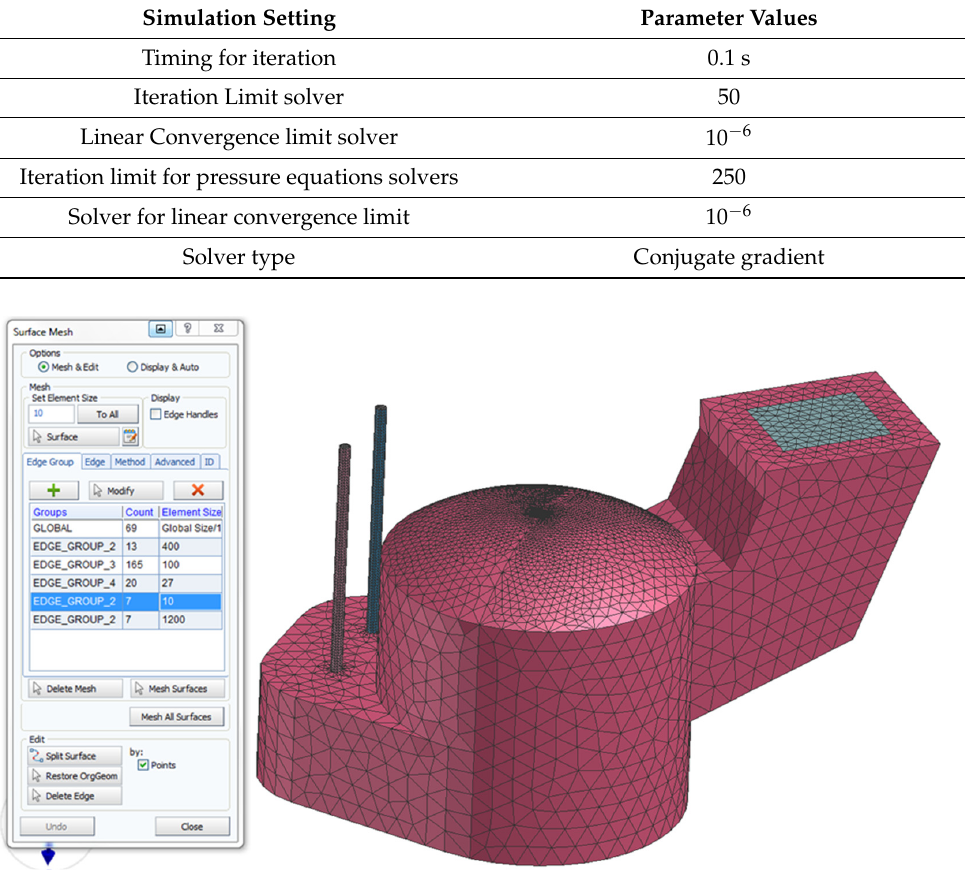
Figure 2. Meshing of the Finite Element Model.